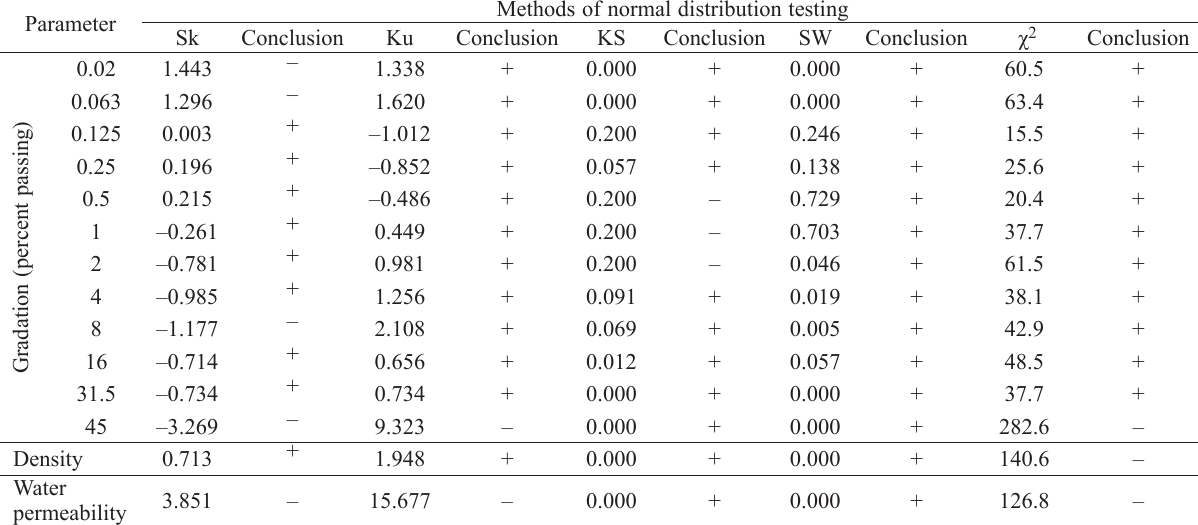
Table 4. Conformity of data distribution to the reguirements of normal distribution